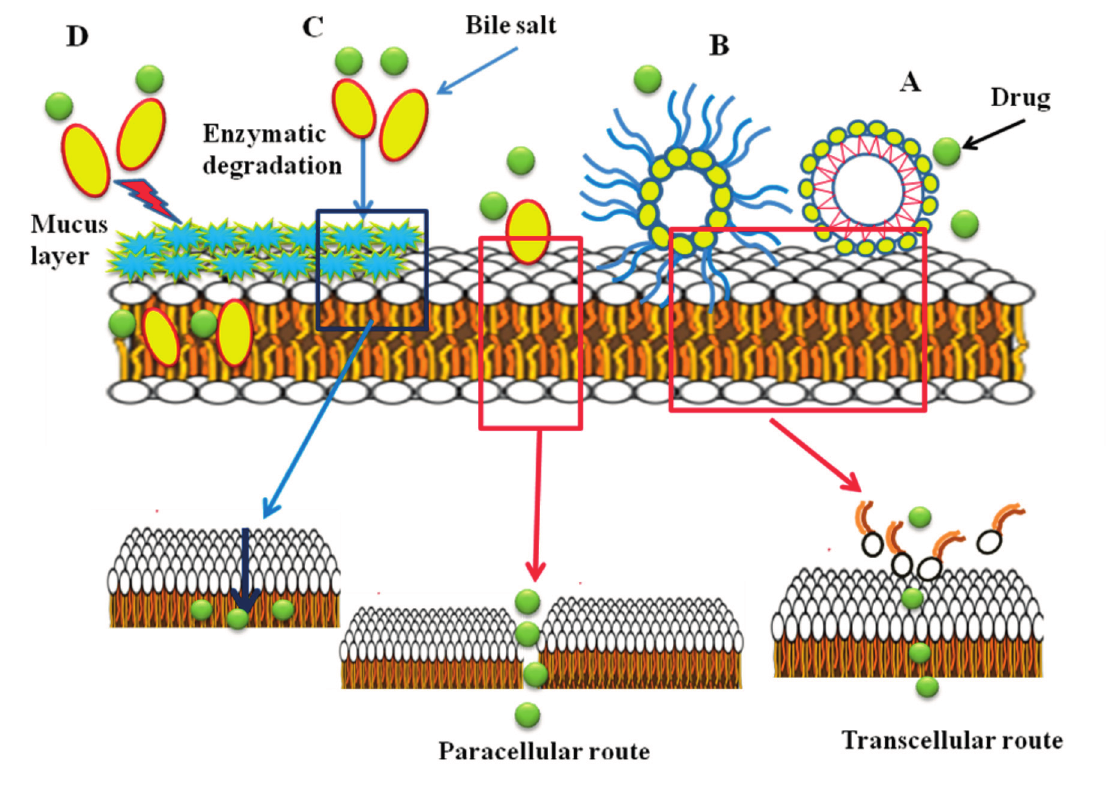
Figure 6. The most common transport mechanisms of bile salts; ( A ) micelle formation; ( B ) reverse micellization; ( C ) enzyme inhibition; ( D ) viscosity reduction of the mucus